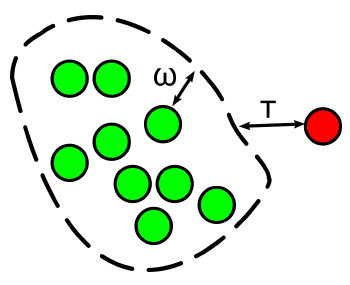
Figure 7. Green and red dots represent normal and abnormal stride instances, respectively. ω determines the distance of the boundary to the normal stride instrances. τ is a threshold to the distance of stride instances: stride instances with a distance larger than τ are classified as abnormal . Table 2. Gait and statistical features used by our approach. Features labeled as accel are computed on all three axes of the linear acceleration and features labeled as all are computed on every axis of the linear acceleration, rotation and on the magnitude vector of the linear acceleration. Feature Signal # peak values accel Gait rise